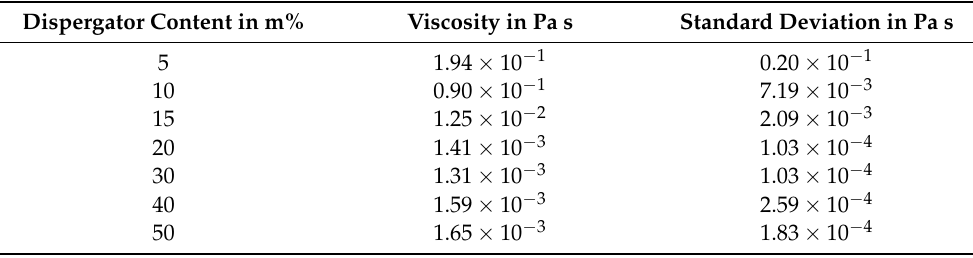
Table A1. Viscosity values as a function of PVP content for an aqueous dispersion containing 10 m% graphite nanoparticles at a pH value of 9.0.